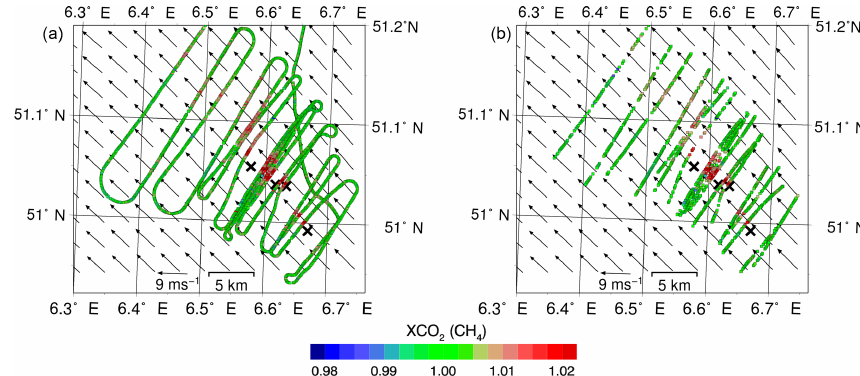
Figure 9. Qualitative MAMAP remote sensing XCO 2 data unfiltered (a) and filtered as described in the main text (b) . The crosses denote the power plant locations (see Fig. 1). Arrows denote wind vectors from the COSMO-DE model at an altitude of about 350ma.m.s.l. (model layer 45) at 13:00UTC. Table 1. Comparison of modelled and measured wind speed for several altitude layers. Altitude Model wind In situ wind Wind speed difference Relative wind speed difference range speed speed (in situ – model) (in situ – model)/model (ma.m.s.l.) (ms − 1 ) (ms − 1 ) (ms − 1 ) (%) 291–440 8.99 8.53 − 5.1